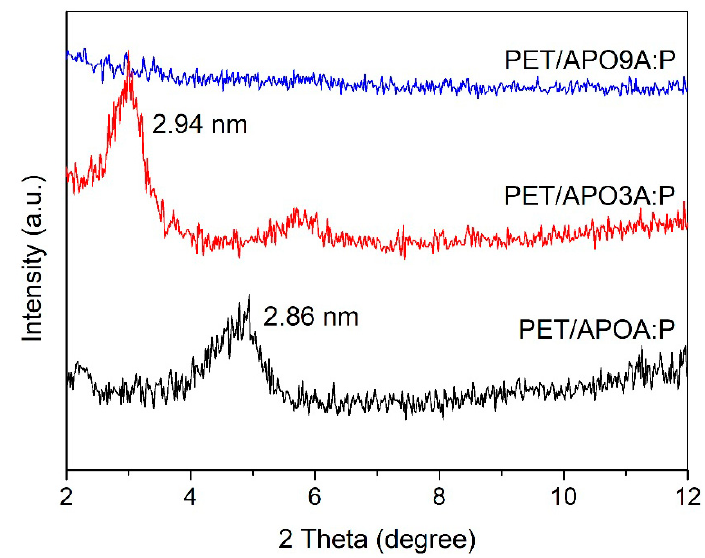
Figure 4. Diffractograms of PET hybrids with 1% by weight of modified AP clay with the mixture of surfactants A-P containing varying amounts of A and P: PET/APOA:P, PET/APO3A:P, and PET/APO9A:P.